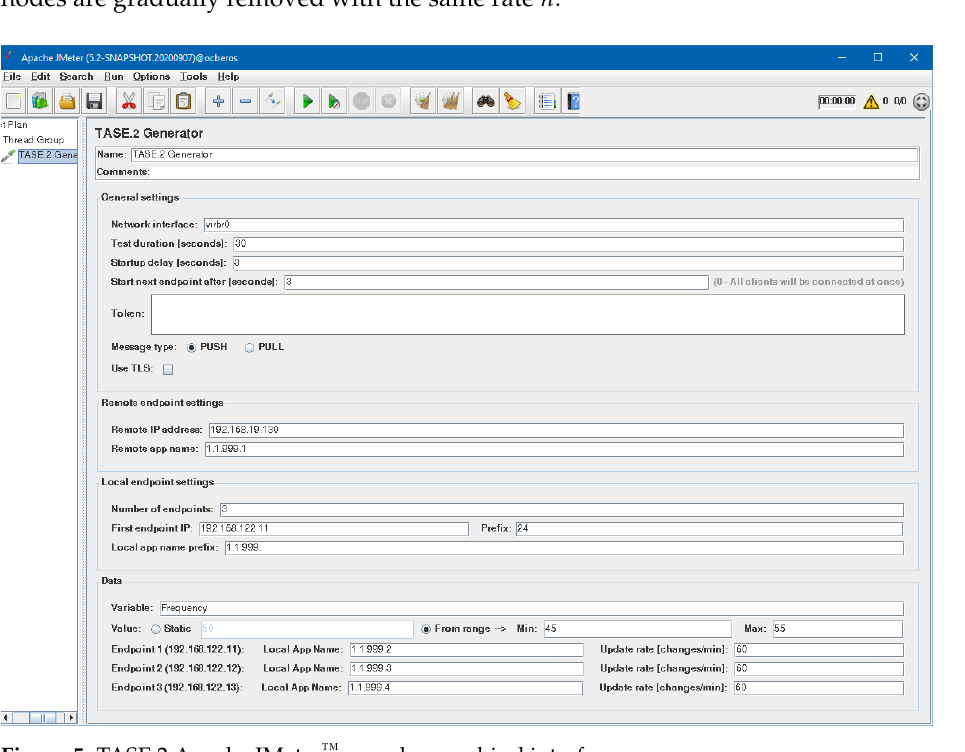
Figure 5. TASE.2 Apache JMeter ™ sampler graphical